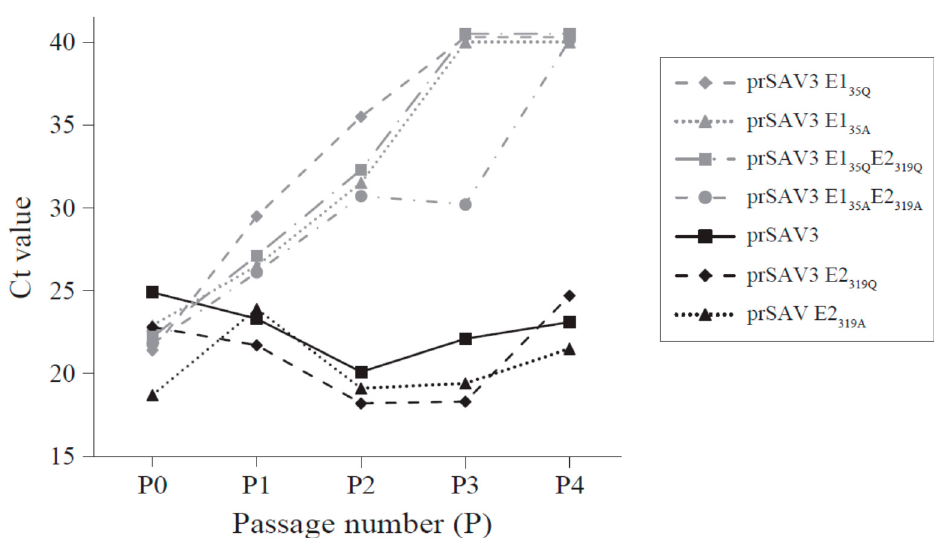
Figure 5. Recovery of the viral RNA in Chum salmon heart-1 cells (CHH-1) supernatant after infection with SAV3 with a mutation in the N-glycosylation sites in E1 and E2. The dots represent Ct values from RT-qPCR run with reverse transcriptase and thus both viral RNA and carryover plasmid DNA. The Ct values of rSAV3, rSAV3 E2 319A and rSAV3 E2 319Q (black dots) constructs decrease for each passage, indicating an increasing viral RNA concentration in the cell culture medium. Ct value for rSAV3 constructs containing mutations in E1 (grey dots), i.e., prSAV3 E1 35Q, prSAV3 E1 35A, prSAV3 E1 35Q / E2 319Q, and prSAV3 E1 35A / E2 319A increase with each passage and no Ct is observed by P4.